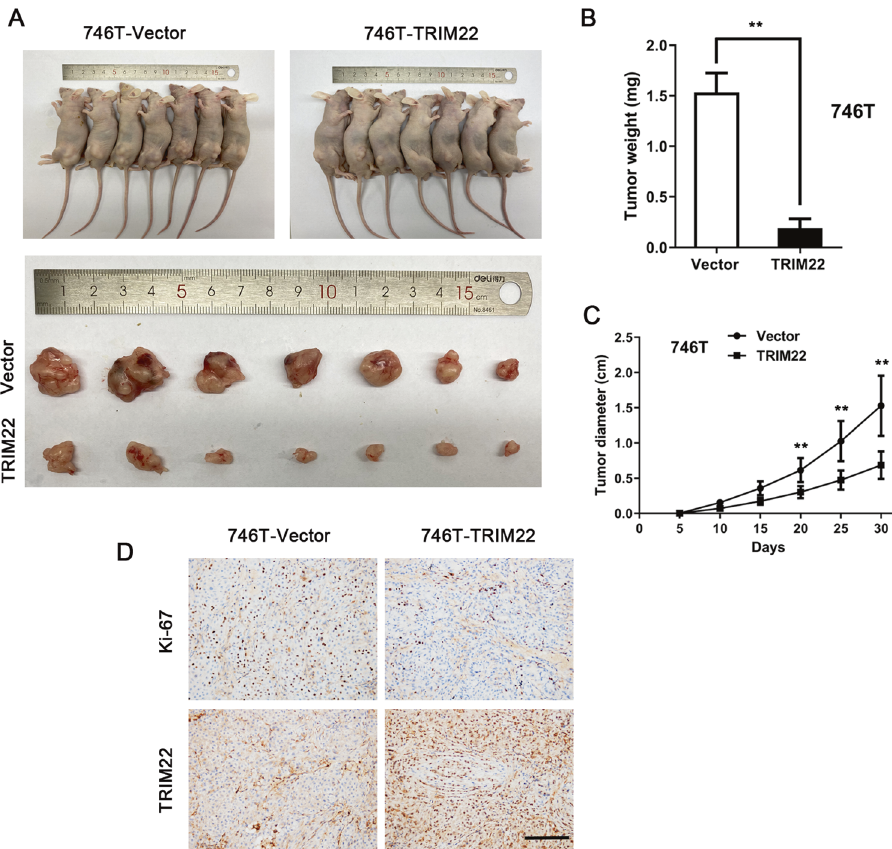
Fig. 6 TRIM22 inhibited the proliferation of gastric cancer cells in vivo. A Image of subcutaneously transplanted tumors in nude mice. B Analysis of tumor weight (** P < 0.01). C Tumor growth curve. D Immunohistochemical staining image of Ki-67 protein, Scale bars = 100 μ m. Data are shown as mean ± SD of three independent